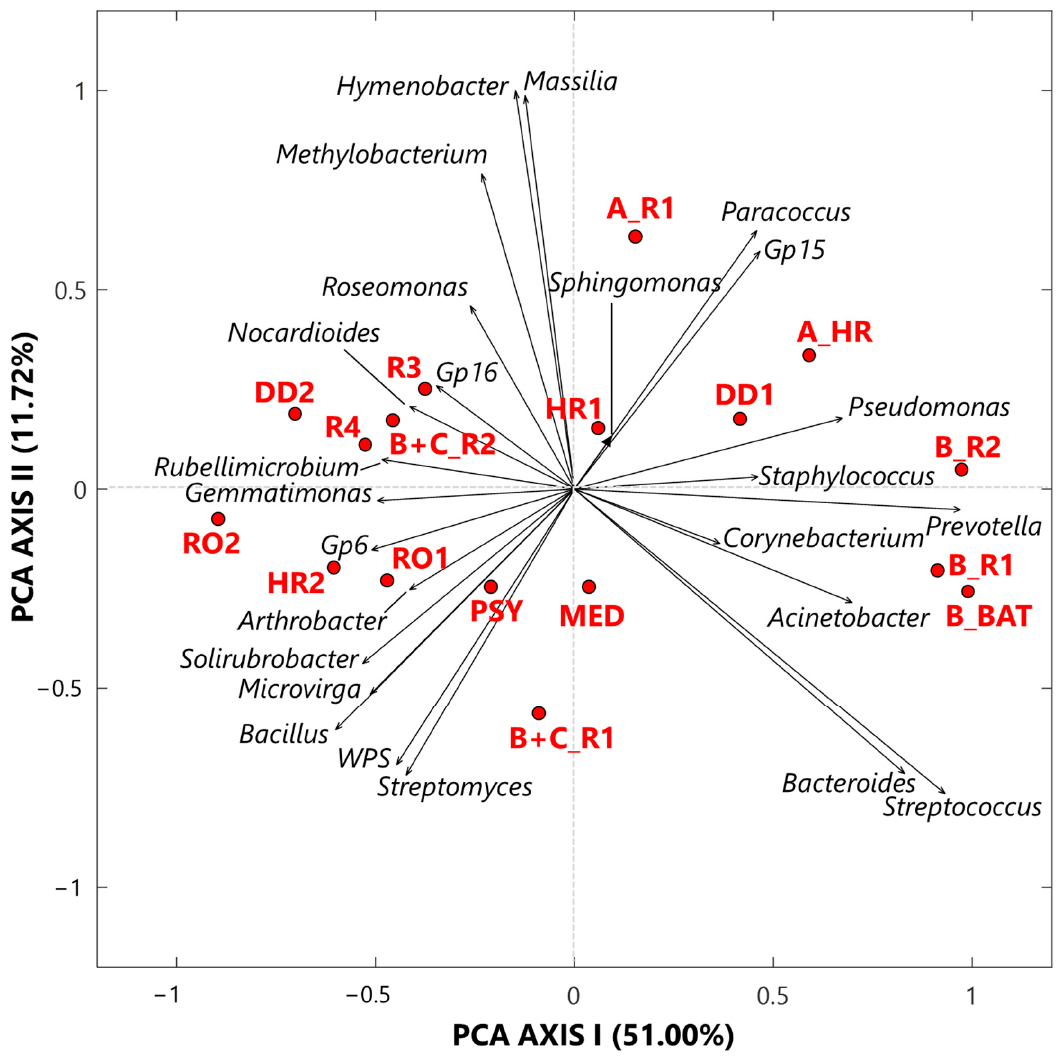
Figure 3. Two-dimensional principal component analysis biplot made via a singular value decomposition of the CLR-transformed values for the 25 selected bacterial genera. The reported biplot illustrates the relationships between samples (score plot, red dots) and genera (loading plot, black arrows). The percentages of the total variance explained by the first and second principal components are also reported. Note that WPS represents WPSUnclassified1_genera_incertae_sedis .